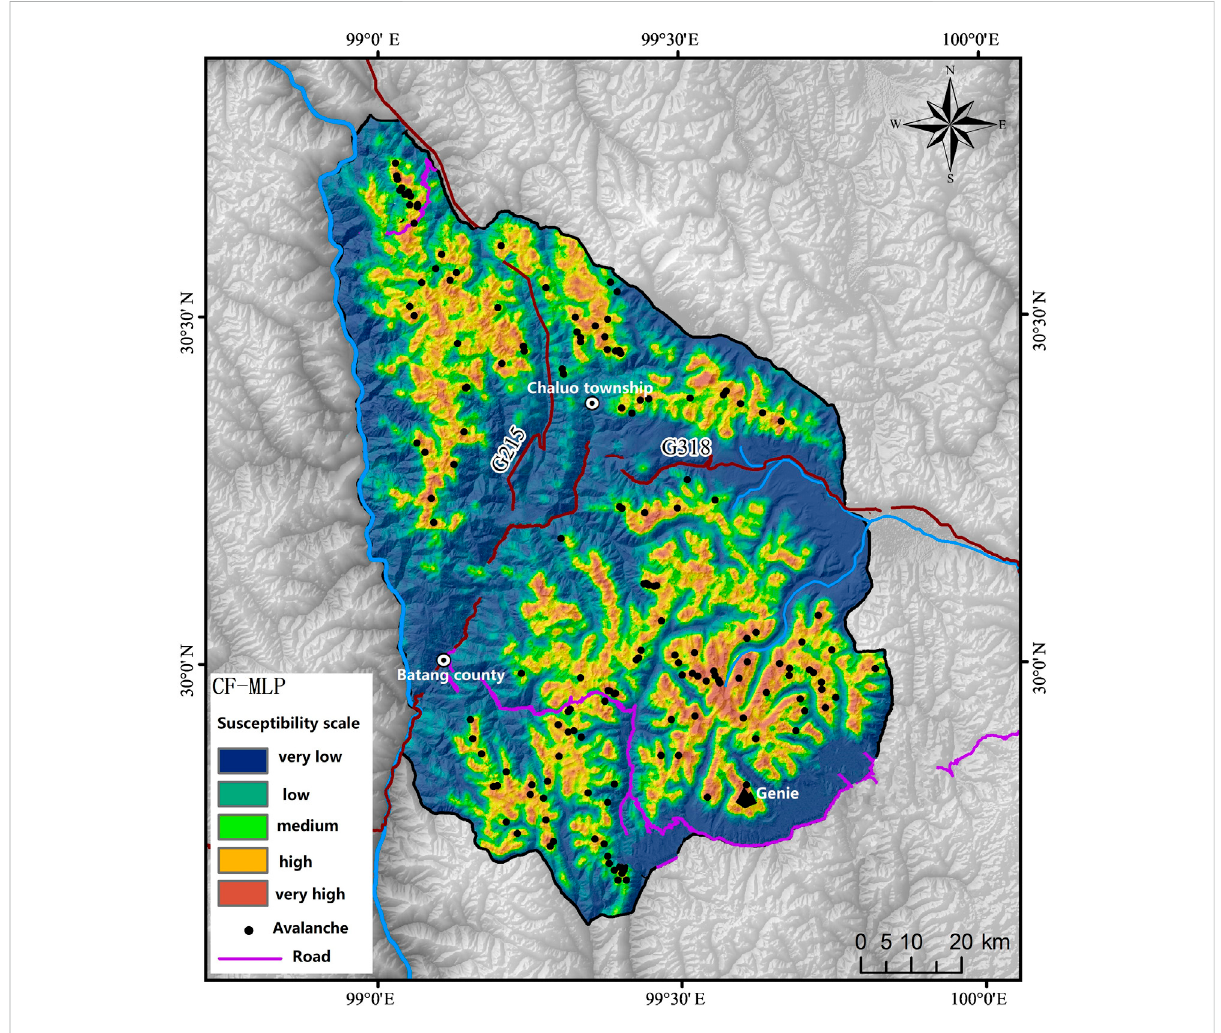
FIGURE 13 Avalanche susceptibility zoning map of the study area by